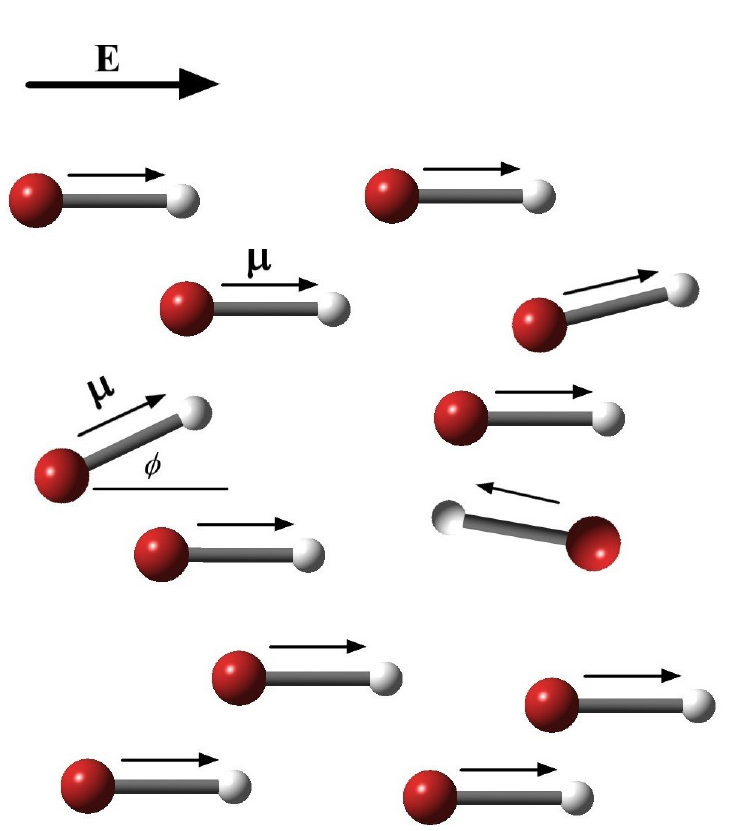
Figure 1. A system of dipoles subjected to external uniform electric field with a magnitude E